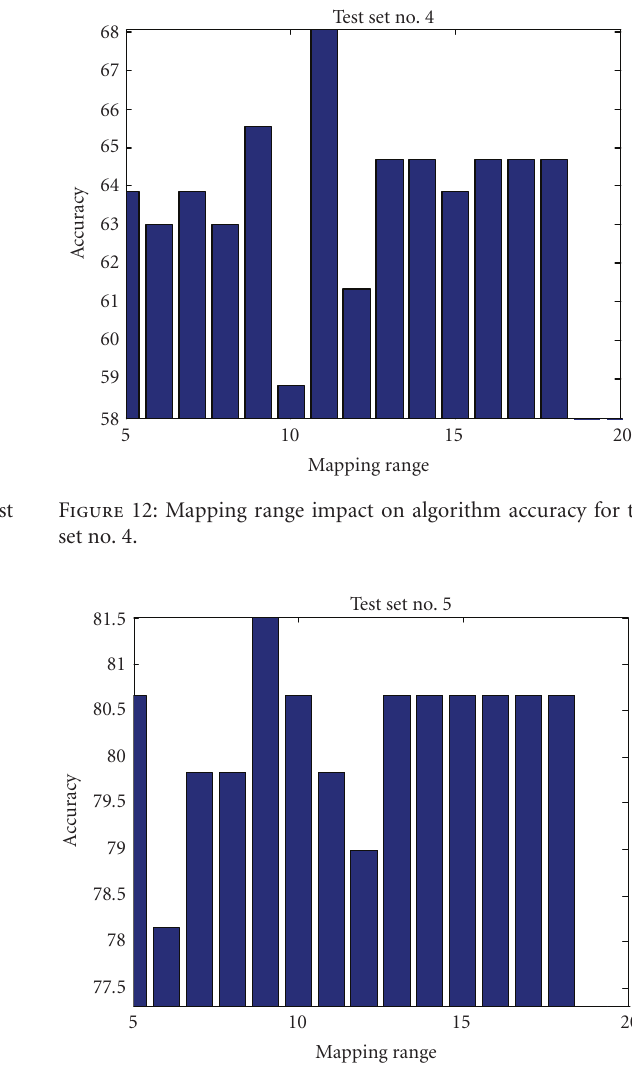
Figure 13: Mapping range impact on algorithm accuracy for test set no.